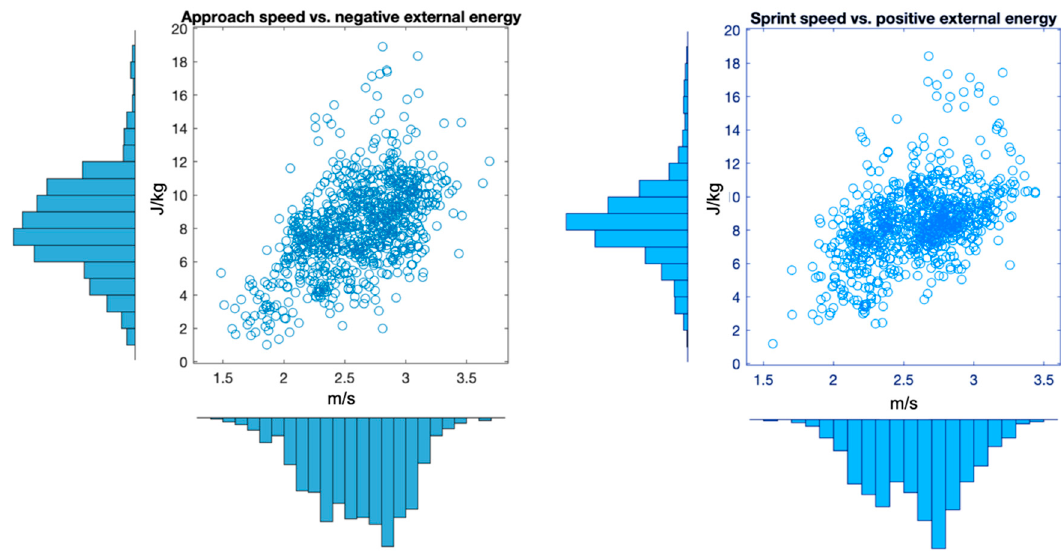
Figure 2. Negative ( left ) and positive ( right ) external mechanical energy computed in the two second window across the turn as a function of running speed before ( left ) and after ( right ) the turn. The distribution of the variables is also displayed on the edges.